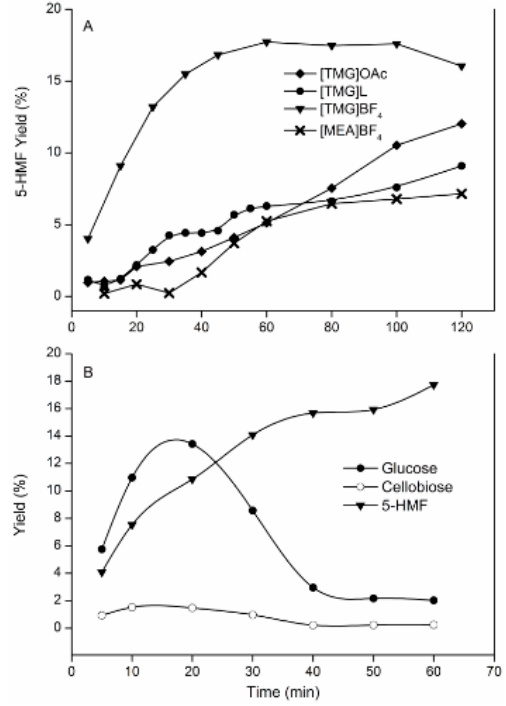
Figure 2. Reaction results of microcrystalline cellulose (MCC) into 5-HMF (( A ) Conversion of MCC to 5-HMF using different ILs; ( B ) The yield of glucose and cellobiose in the conversion of MCC into 5-HMF catalyzed by [TMG]BF 4 ). Conditions: MCC (0.5 g), IL (0.25 g), 5 wt % DMAc-LiCl (60 mL), 160 ◦ C.